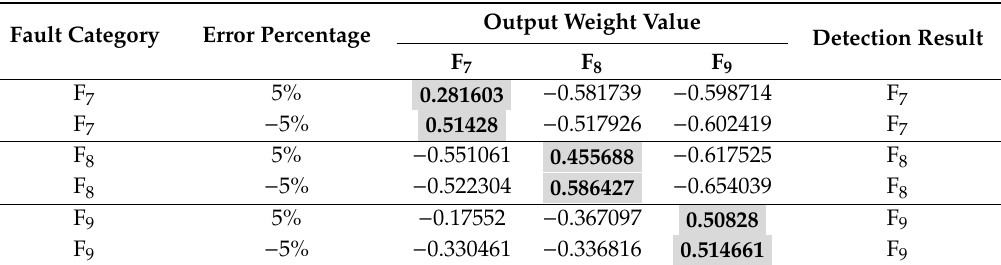
Table 8. Fault detection results under the failure of di ff erent switches in c -phase and addition of ± 5% erroneous data (inverter frequency = 60 Hz).